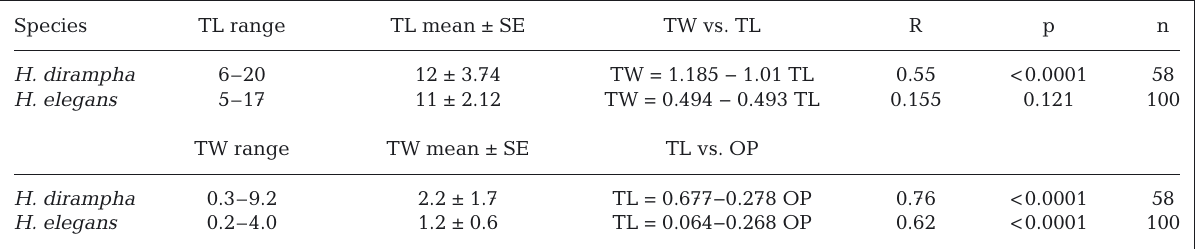
Table 1. Hydroides dirampha and H. elegans total length (TL, mm) and total weight (TW, mg) (range and mean ± SE) and linear regression between TW and TL and between TL and operculum plus peduncle